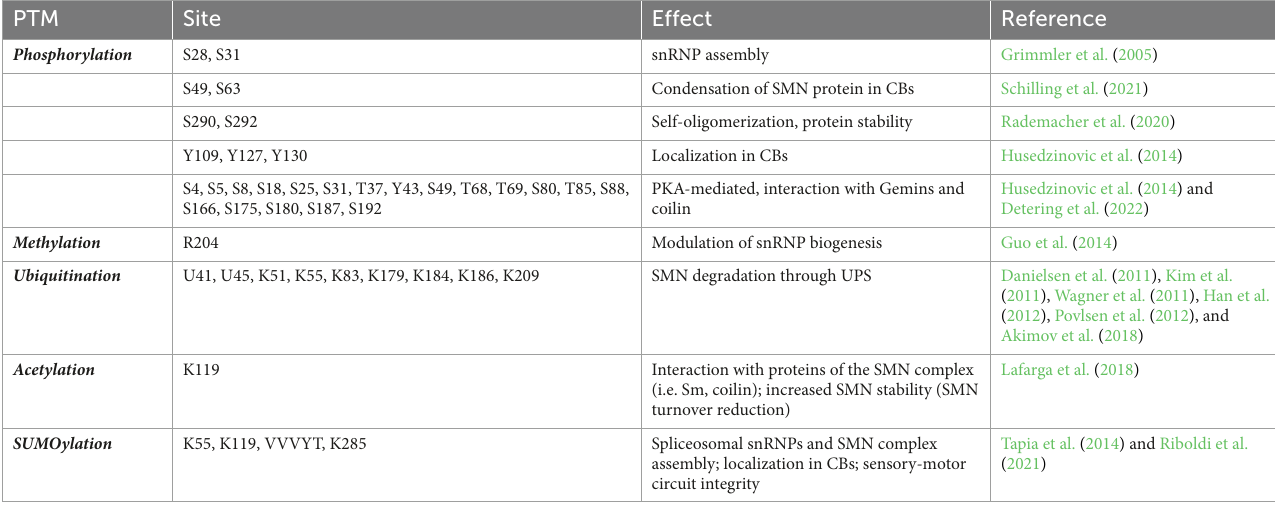
TABLE 1 Site of SMN PTMs and their